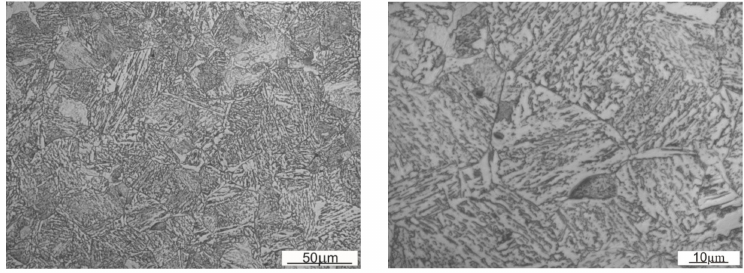
Figure 8. Microstructure of roller press molding ring made of 20Cr4